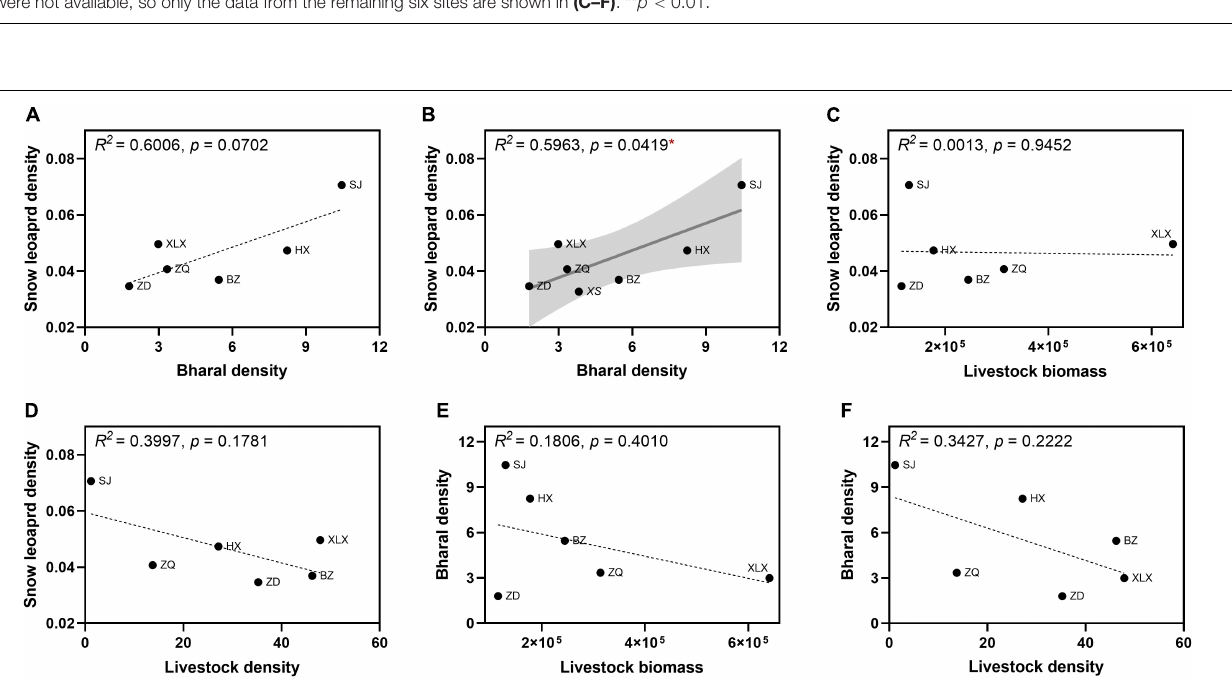
FIGURE 6 | Correlations between snow leopard density and prey (bharal and livestock) abundance (A–D) , and between bharal density and livestock abundance (E,F) at the study sites. (A) Includes data from six study sites and (B) includes the same data plus field survey data from an additional site on the Qinghai-Tibetan Plateau: Xueshan (XS). See Figure 5 for explanations of data sources, sampling sites, and graphical elements and interpretations. * p < 0.05.